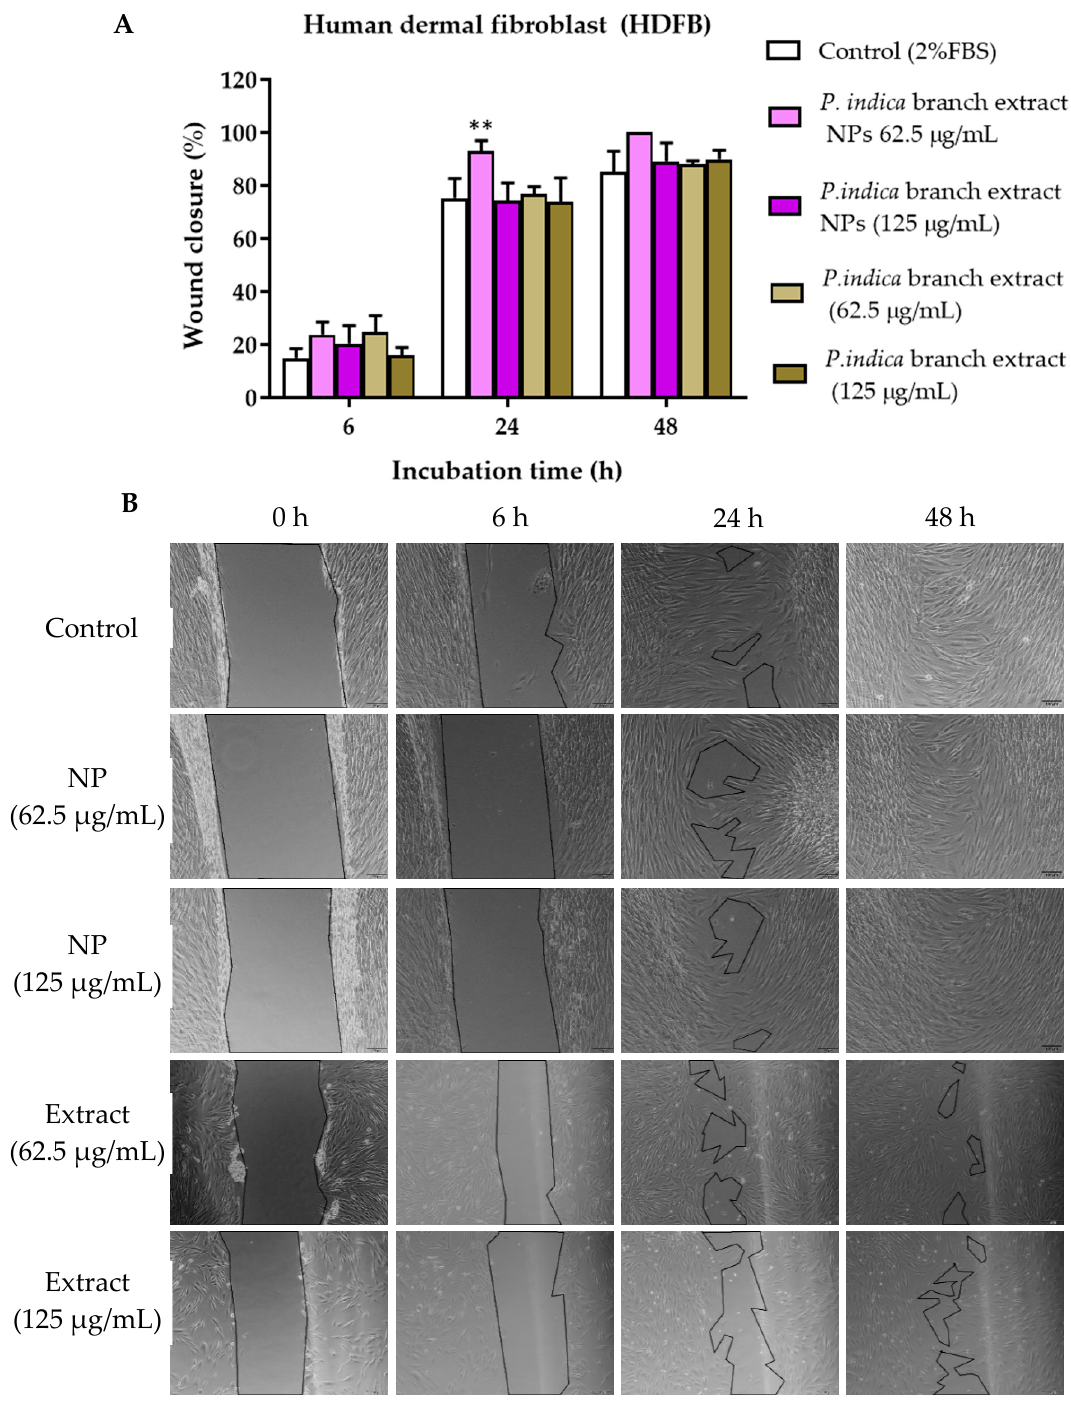
Figure 8. ( A ) Microscopic images of human dermal fibroblasts treated with P. indica branch extract in the scratch assay. ( B ) The images were captured at 0, 6, 24, and 48 h after incubation. The data represent the mean ± SEM of three experiments. ** indicates p < 0.01 compared with control.